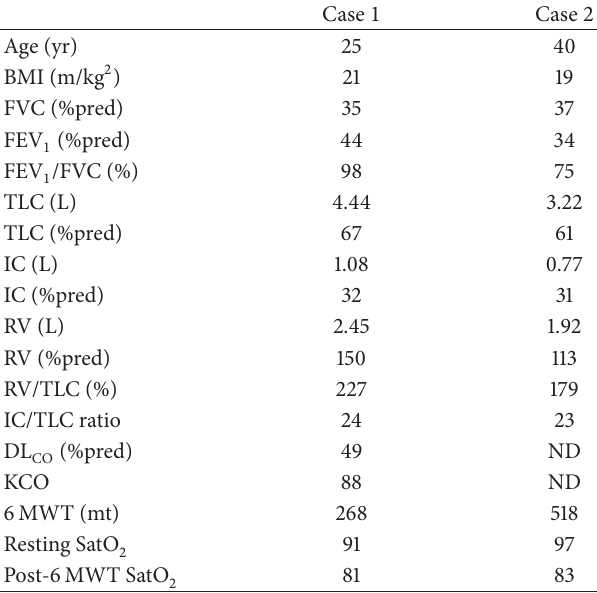
Table 1: Anthropometric and functional characteristics of two cases with pleuropulmonary